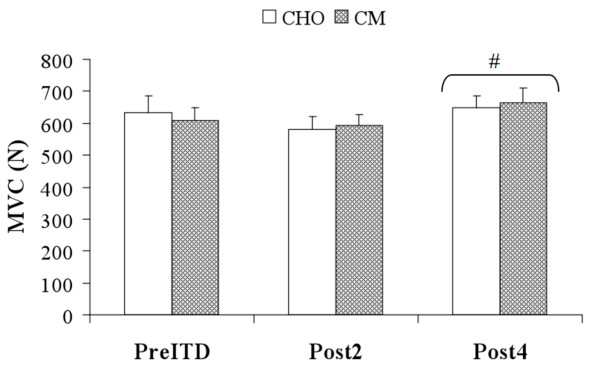
MVC levels following Increased Training Duration. Data reported are means/standard error. [# = significantly different (p < 0.05) than PreITD].